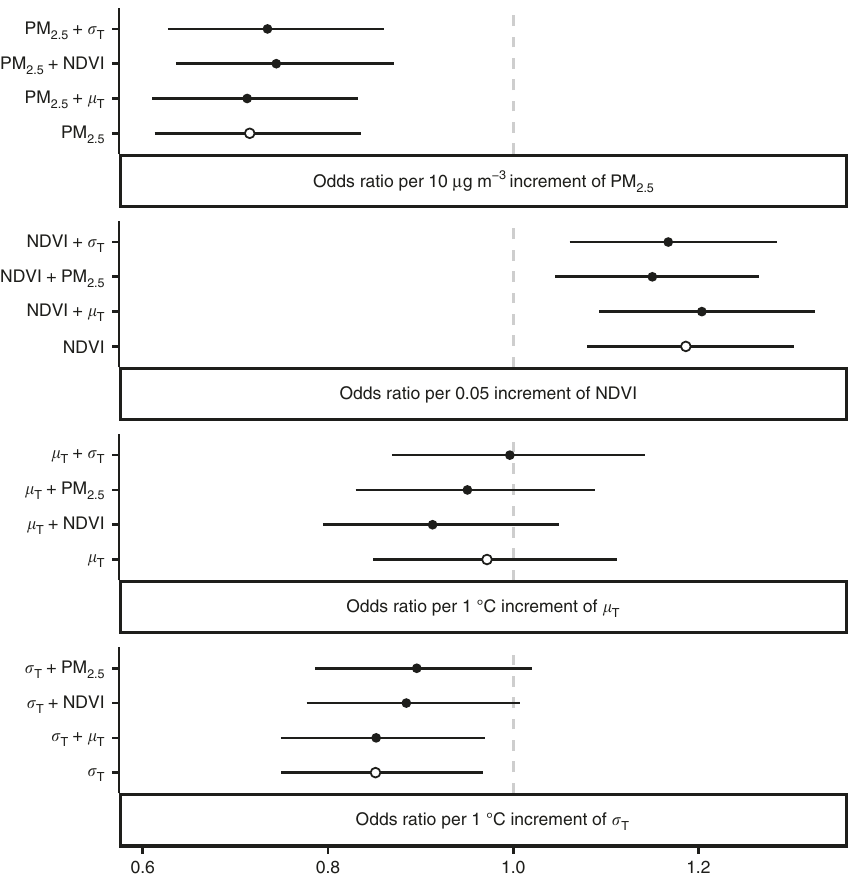
Fig. 3 Results of the double-exposure models. In each panel, the fully adjusted odds ratios of an environmental factor with their 95% con fi dence intervals (black dots with error bars) estimated by the double-exposure models are compared with the estimate of the corresponding single-exposure model (black circles with error